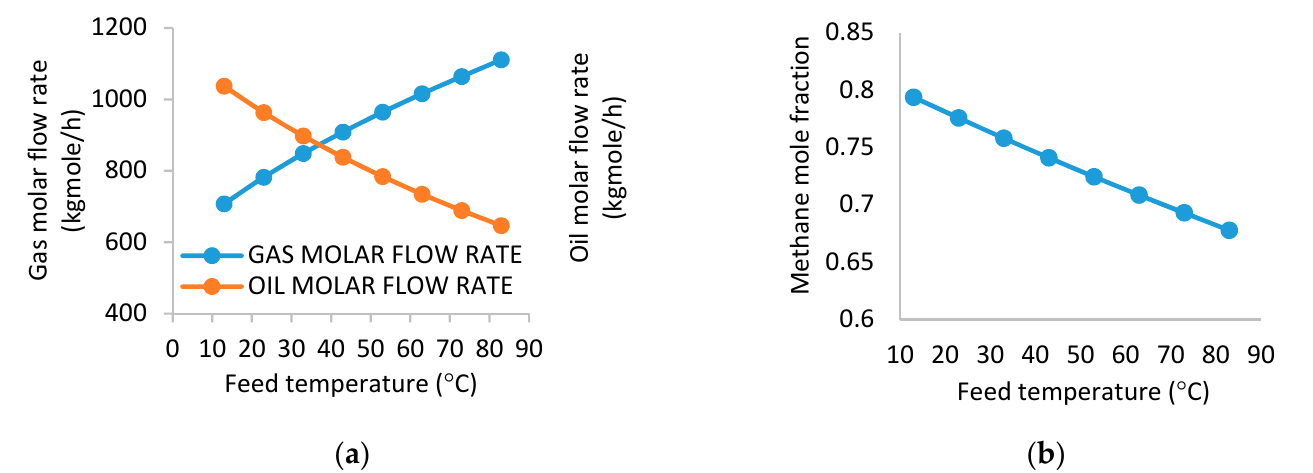
Figure 3. ( a ) Effect of temperature on gas molar flow rate and oil molar flow rate. ( b ) Effect of separator temperature on methane mole fraction.